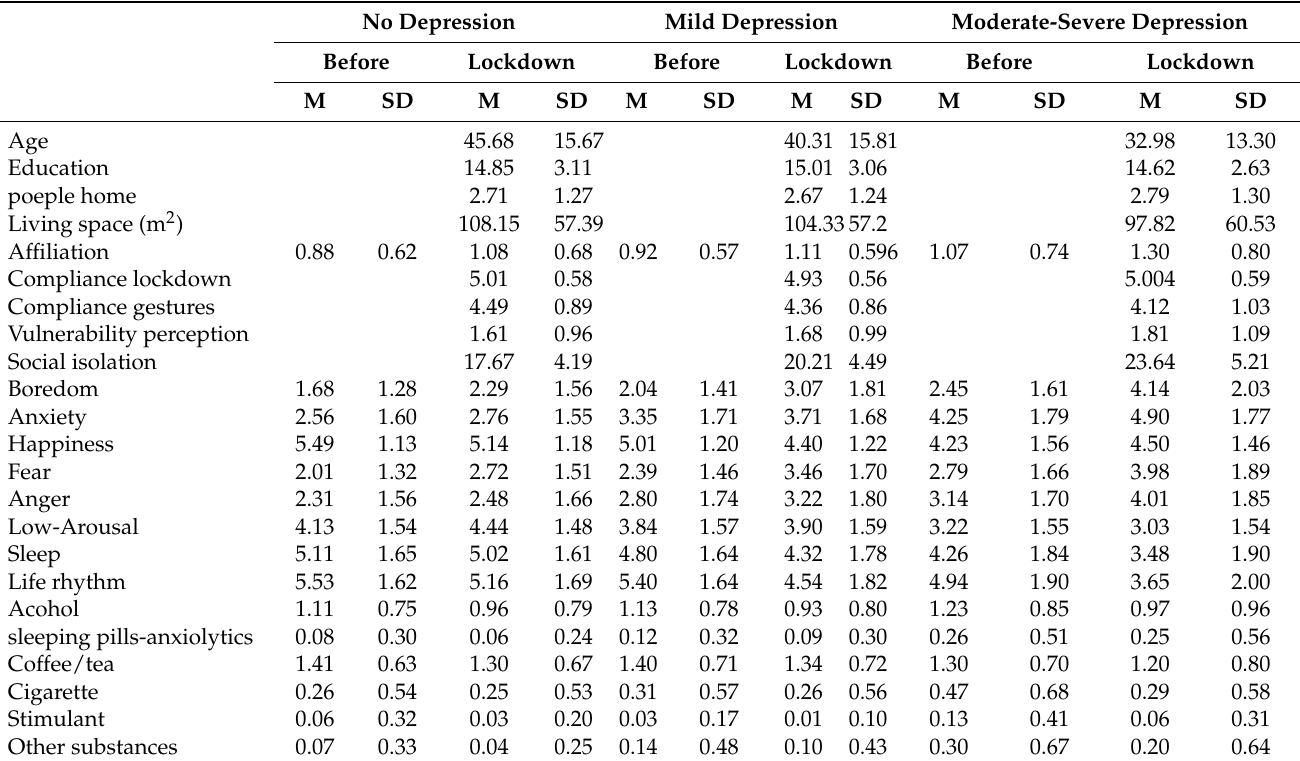
Table 1. Mean (SD) of the participants’ answers to the survey questions used in Study 1 according to depressive symptoms: no, mild and moderate-severe.